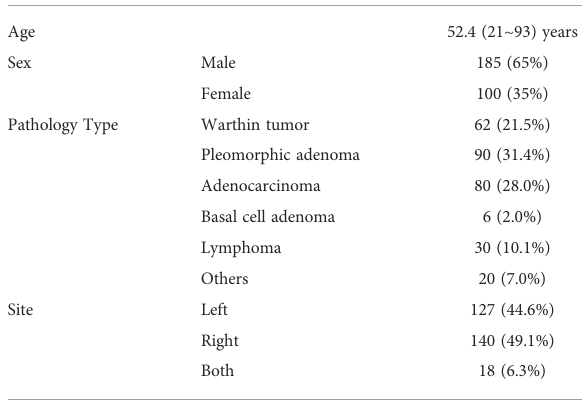
TABLE 1 Patient